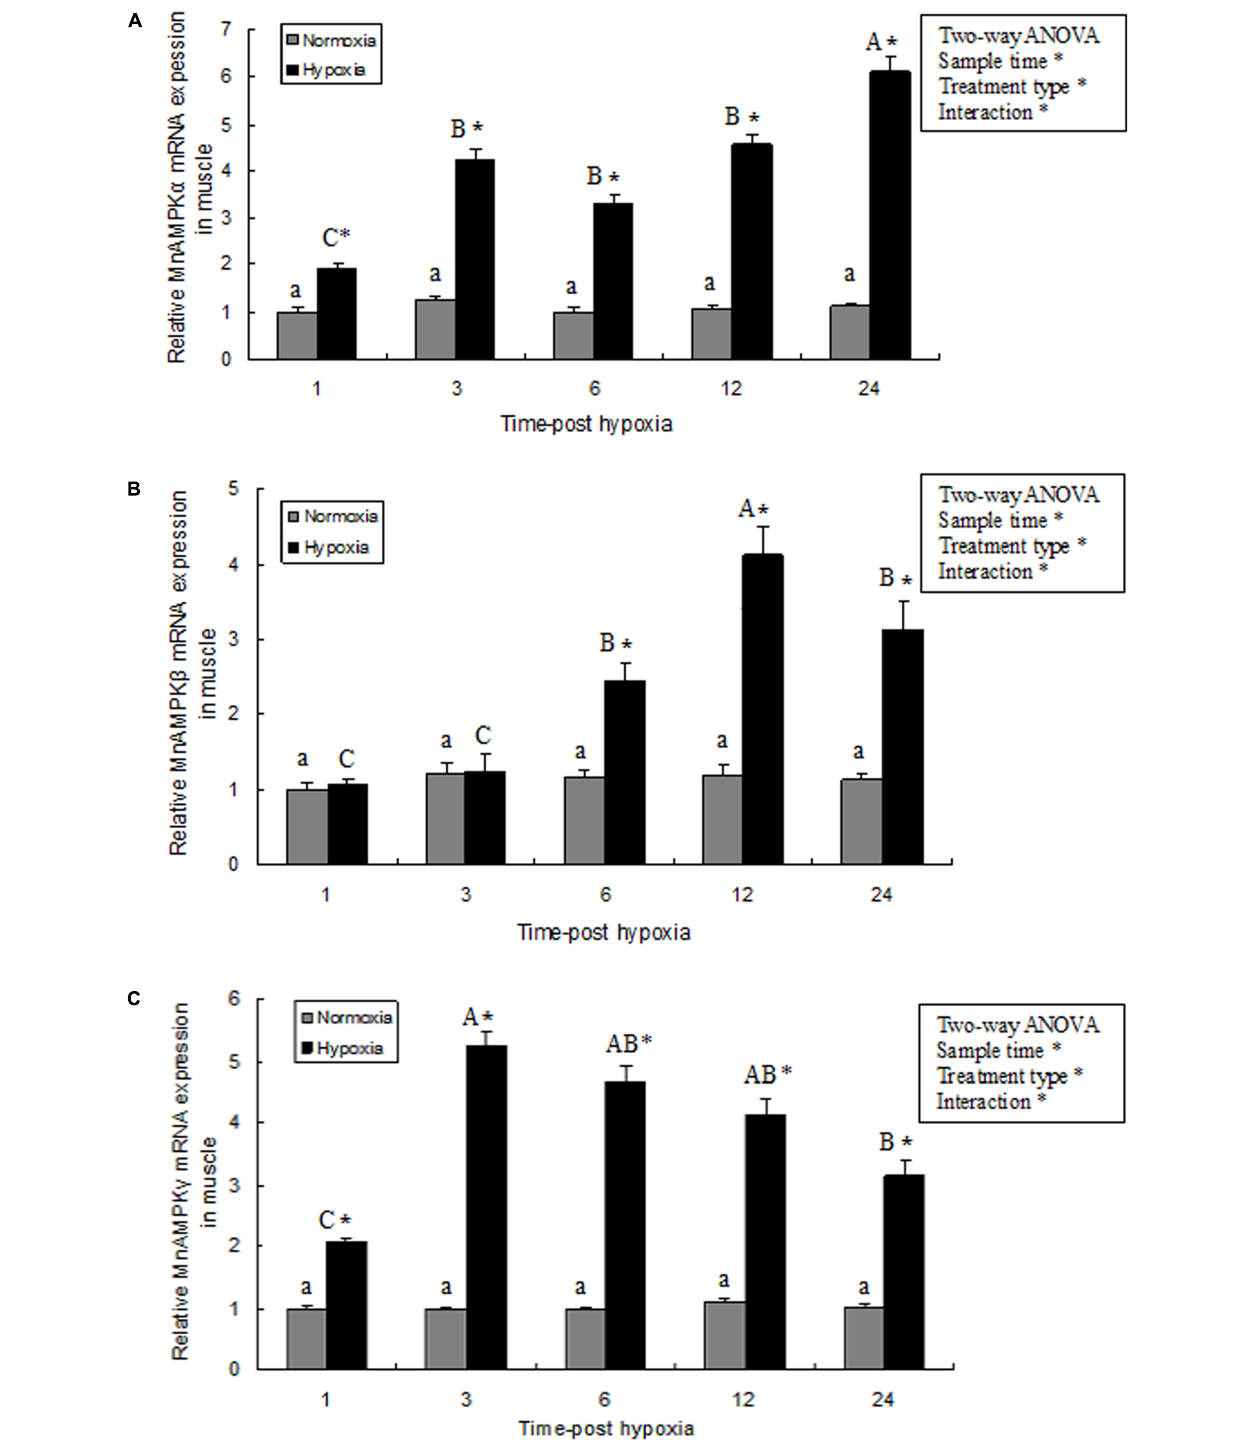
FIGURE 3 | The effect of hypoxia on AMPK α (A) , AMPK β (B) , and AMPK γ (C) mRNA expression levels in muscle tissue in M. nipponense . mRNA expression of the AMPK subunits ( α , β , and γ ) was normalized to the expression level in the normoxia group. Values are expressed as the mean ± SE ( n = 9). Significant differences ( P < 0.05) among sampling times within each treatment are indicated by different letters (upper case for hypoxia, and lower case for mormoxia). Student’s t -test was used to compare expression between the hypoxia and control groups. Error bars indicate the standard error and asterisks indicate significant differences between the hypoxia and normoxia groups ( P <